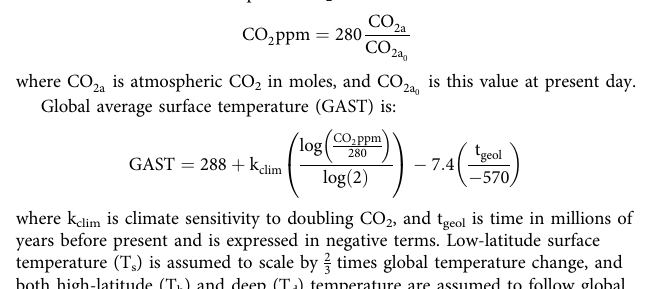
Methods Model derivation . This model is designed to track the transfer and isotopic sig- nature of atmospheric and marine carbon and mercury over geological time, while being broadly applicable to changes on the timescale of ocean circulation. The biogeochemical system is taken largely from ref. 36 , with some additions from refs. 37,53,54 , with the underlying hydrological model from ref. 35 . The Hg cycle follows ref. 25 . Model structure . The model has three ocean boxes: surface (s), high latitude (h) and deep (d). As in ref. 35 , the surface box is 100-m deep and occupies 85% of the ocean surface, whereas the high-latitude box is 250-m deep and represents 15% of the ocean surface. Each ocean box includes the same biogeochemical species, and a thermohaline circulation mixes the boxes in the order s, h, d. The upper boxes exchange with the atmosphere, which is a single box. As well as transfer fl uxes between ocean and atmosphere boxes, biogeochemical fl uxes of weathering, degassing and burial operate between the surface system and crust. Model species . All model species are shown in Table 1. Model fl uxes . Model fl uxes, with equations and present values are shown in Table 2. Non- fl ux calculations . Atmospheric CO 2 volume ratio is calculated as: